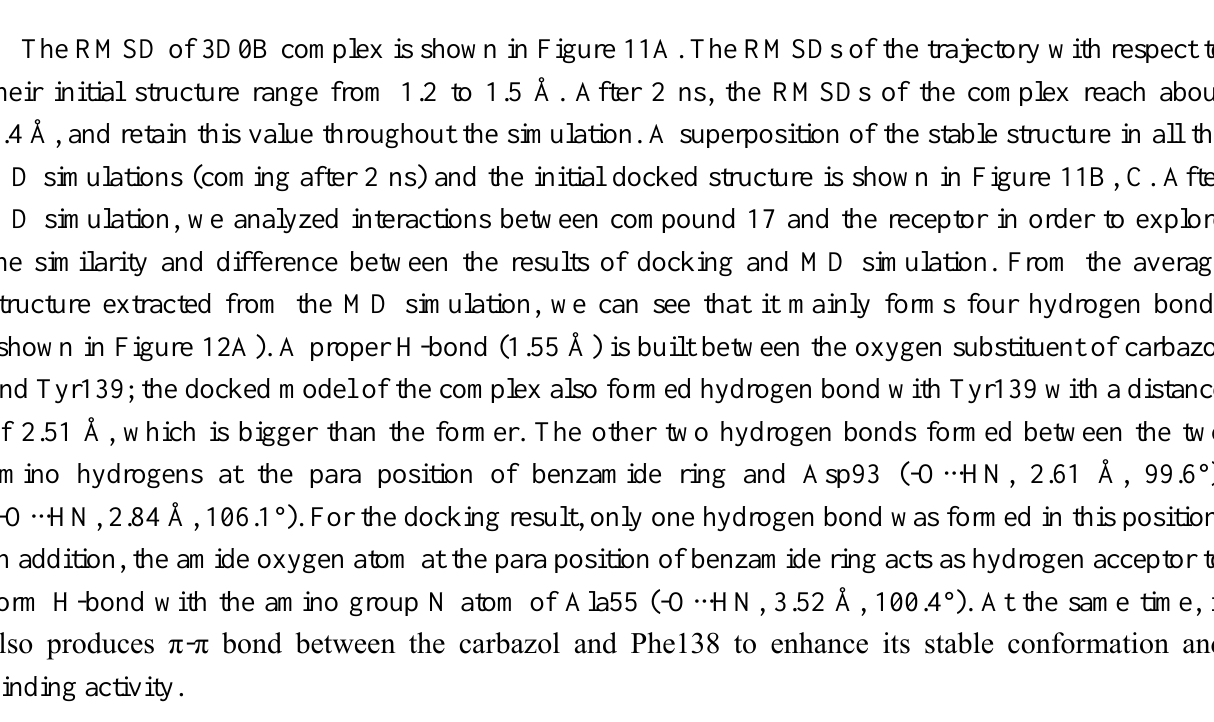
Figure 11. ( A ) Plot of the root-mean-square deviation (RMSD) of docked complex versus the MD simulation time in the MD-simulated structures; ( B ), ( C ) View of superimposed backbone atoms of the lowest energy structure of the MD simulation (cyan) and the initial structure (green) for compound 17-3D0B complex. Compound 17 is represented as carbon-chain in green for the initial complex and carbon-chain in cyan for the lowest energy